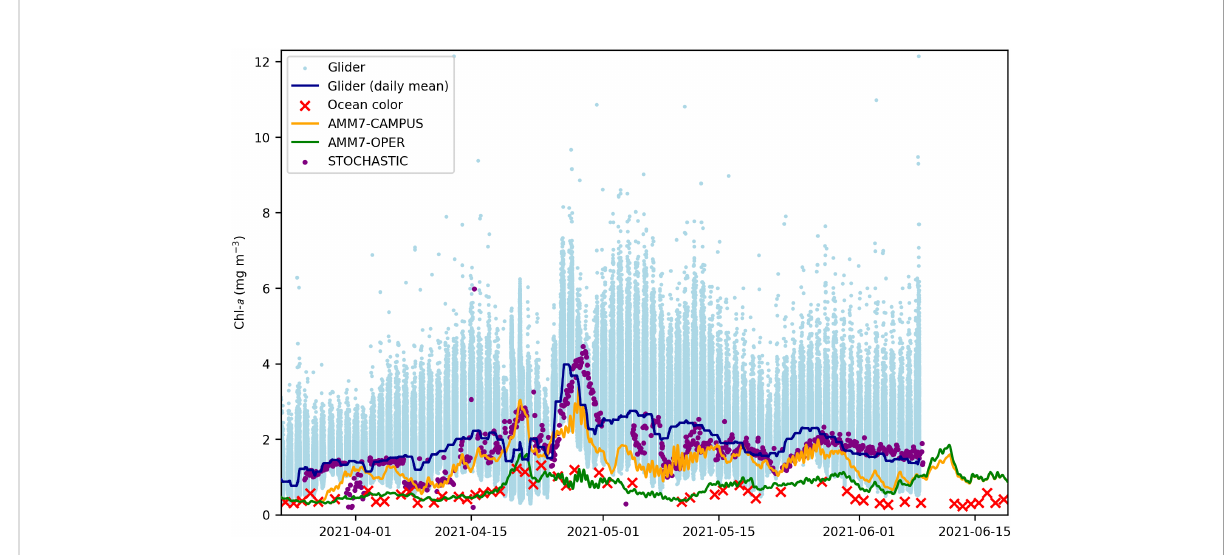
FIGURE 7 Time series of near-surface chl- a in the glider region from the nighttime glider observations, ocean color, AMM7-CAMPUS best estimate, AMM7-OPER best estimate, and STOCHASTIC four-hour